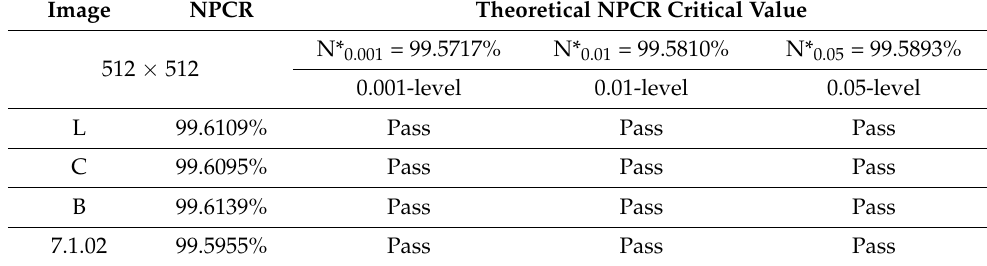
Table 2. The NPCR statistical test on key